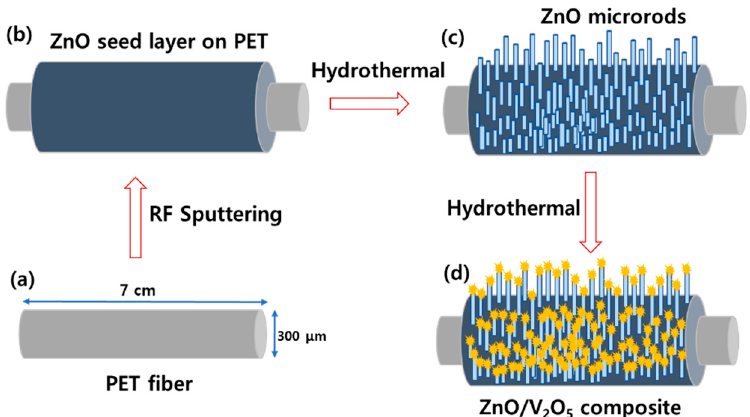
Figure 1. Photographic image of ZnO/V 2 O 5 deposited PET single fiber ( a ) at straight and ( b ) full- bending conditions.